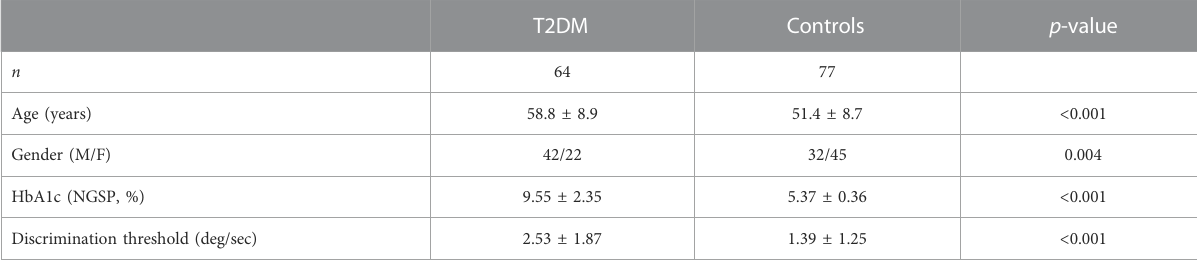
TABLE 1 Characteristics of the study participants and identi fi cation of